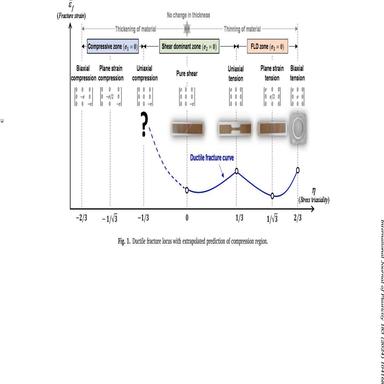
Ductile fracture locus with extrapolated prediction of compression region.